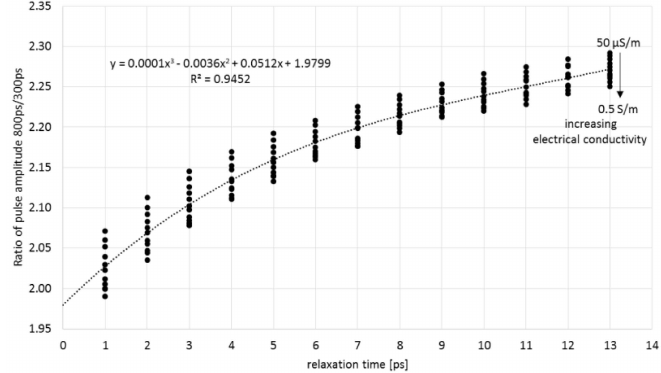
Figure 8. The relationship between the amplitude ratio of 800 ps and 300 ps pulses and relaxation time for simulation parameters: ε 8 = 5, ε s = 80, σ P [50 µ S ¨ m ´ 1 , 0.5 S ¨ m ´ 1